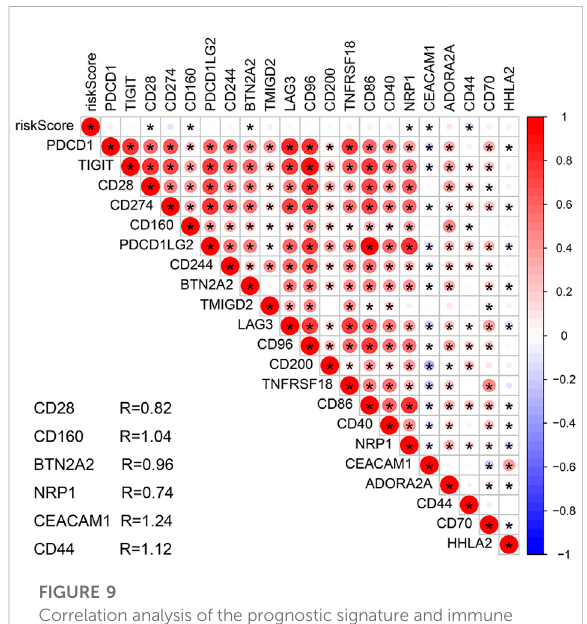
FIGURE 9 Correlation analysis of the prognostic signature and immune checkpoint-related